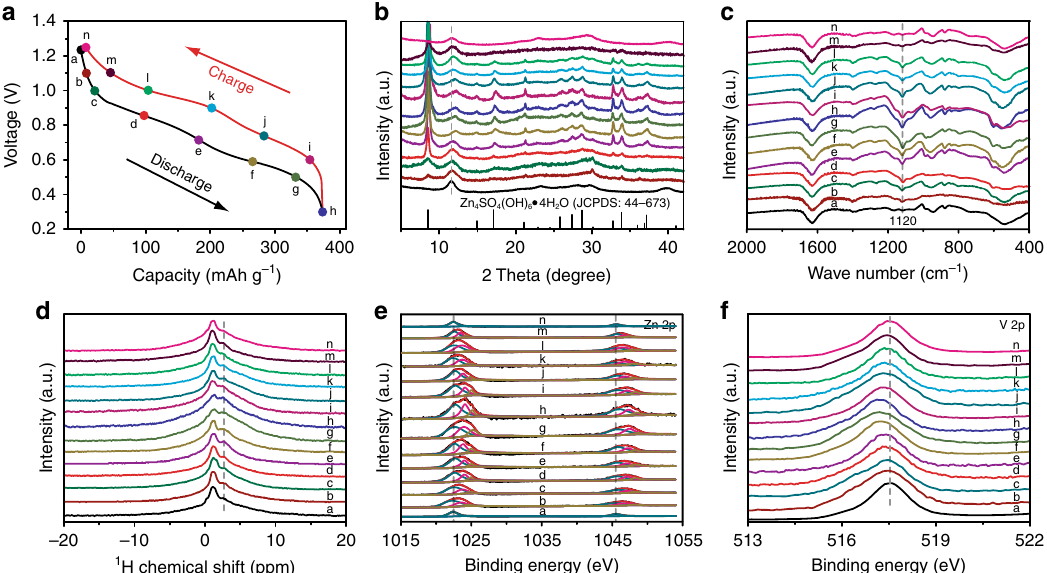
Fig. 5 Simultaneous H + and Zn 2 + insertion/extraction mechanism. a Second charge/discharge curve of NVO nanobelts at 0.1 A g – 1 . Ex situ b XRD